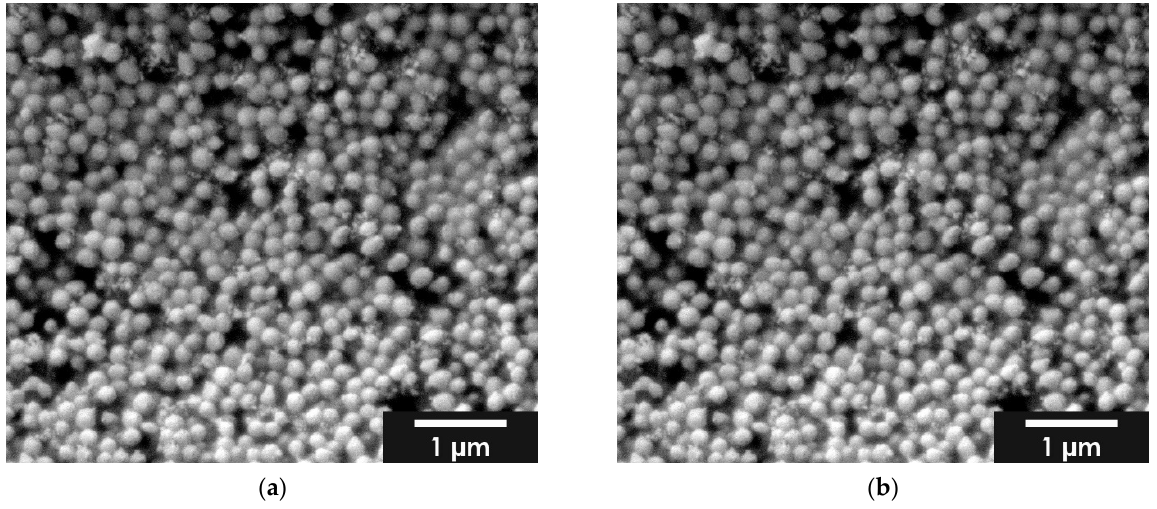
Figure 3. ESEM images of BMP-2 loaded GNP; ( a ): 1% w / v BMP-2; ( b ): 2% w / v BMP-2; images taken with FEI Quanta 250 FEG at 12 kV acceleration voltage, all samples were sputter coated (JEOL, JFC-1200) with a 25 nm Gold layer.